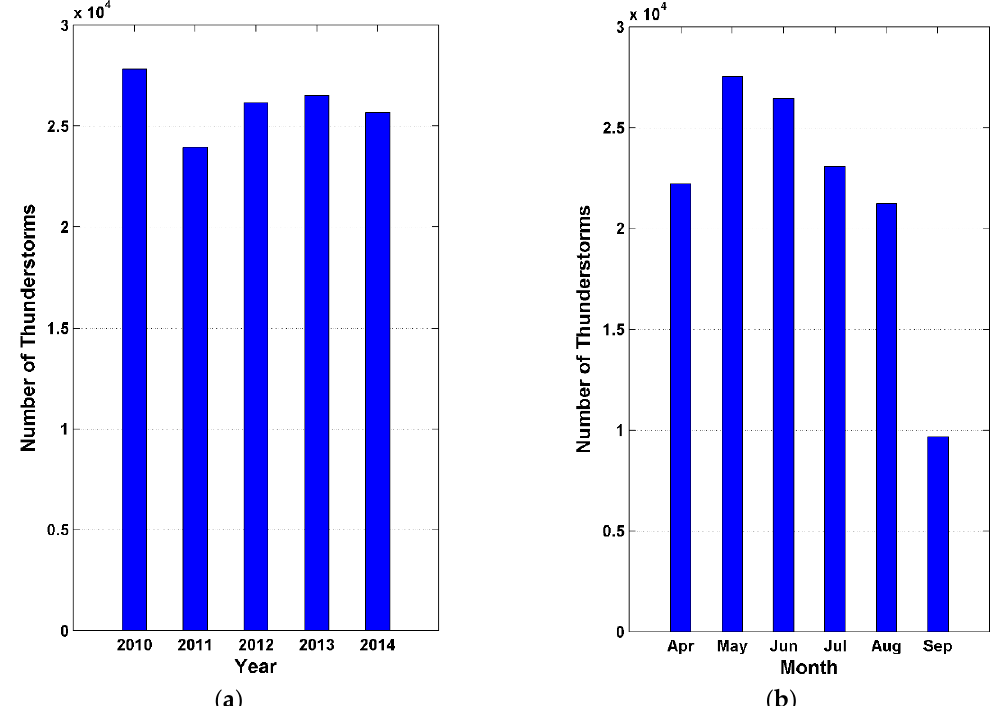
Figure 5. ( a ) Annual; ( b ) monthly thunderstorm occurrences in the study area during warm seasons (April to September) from 2010 to 2014.